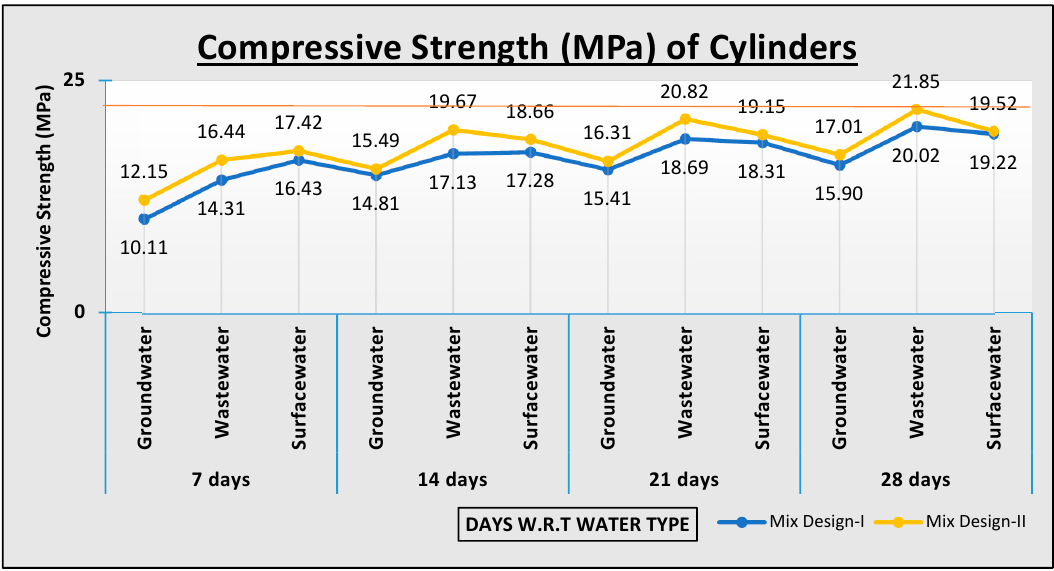
Figure 10. Comparative analysis for the impact of water quality on compressive strength with respect to mix design.